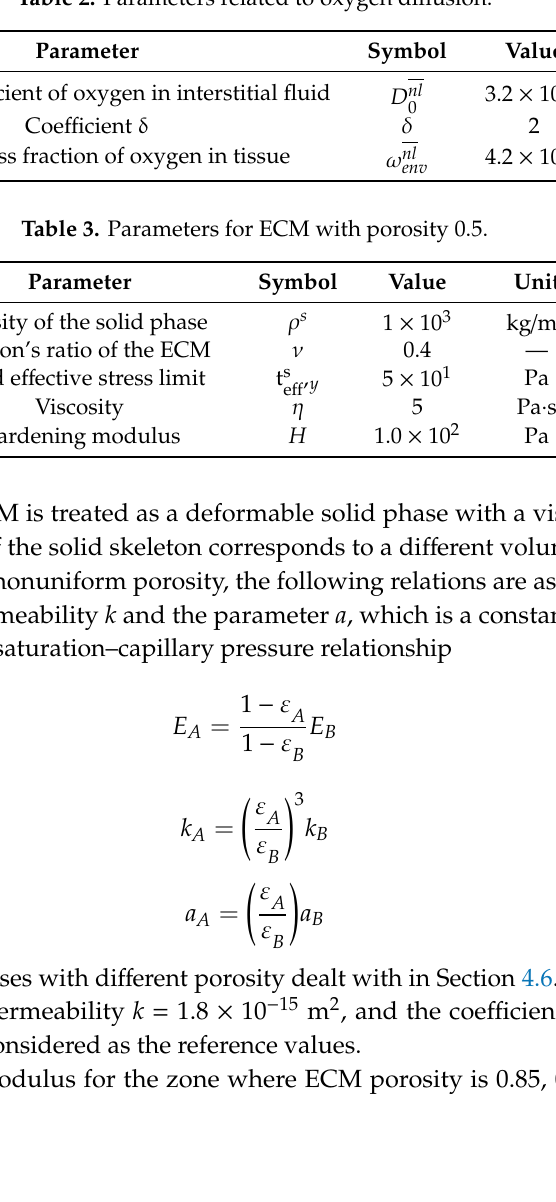
Table 2. Parameters related to oxygen di ff usion.